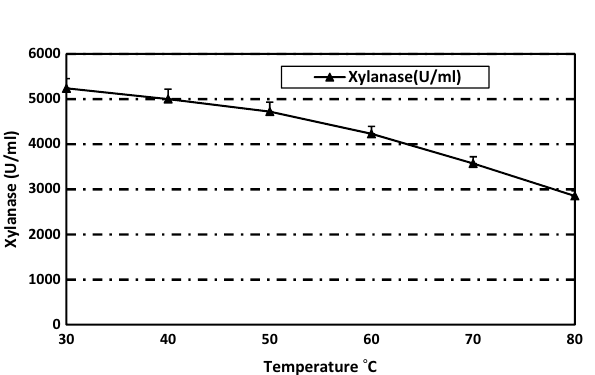
Figure 2. Temperature optima of the purified xylanase from Paecilomyces variotti.